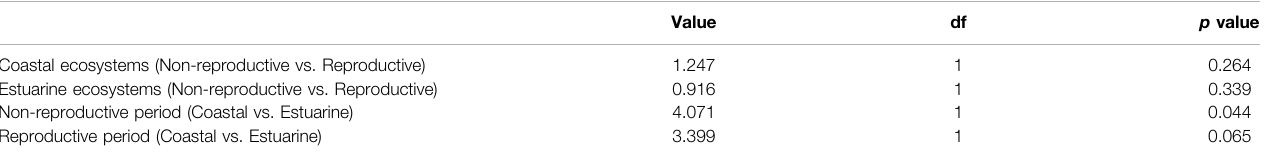
Value df p value